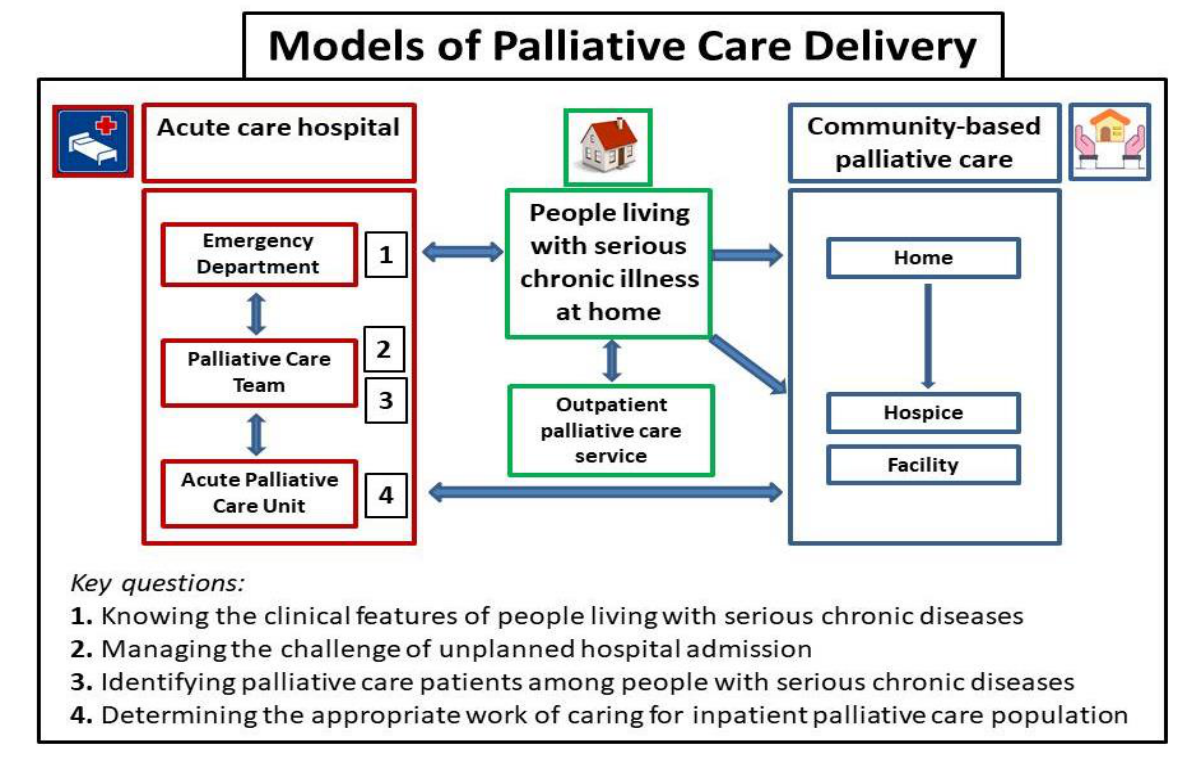
Figure 3. Models of palliative care